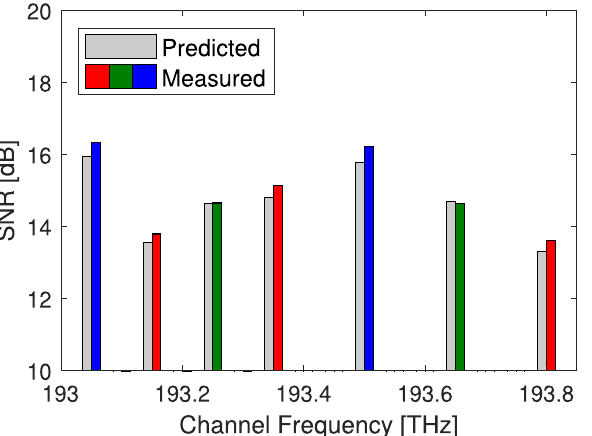
Figure 2. Received performance. Measured performance and predicted performance of signals propagated around the virtual ring. The performance histograms are grouped around the channel frequency. Signals transmitted from UoC, UoB and UCL are coloured red, green and blue respectively 21 .